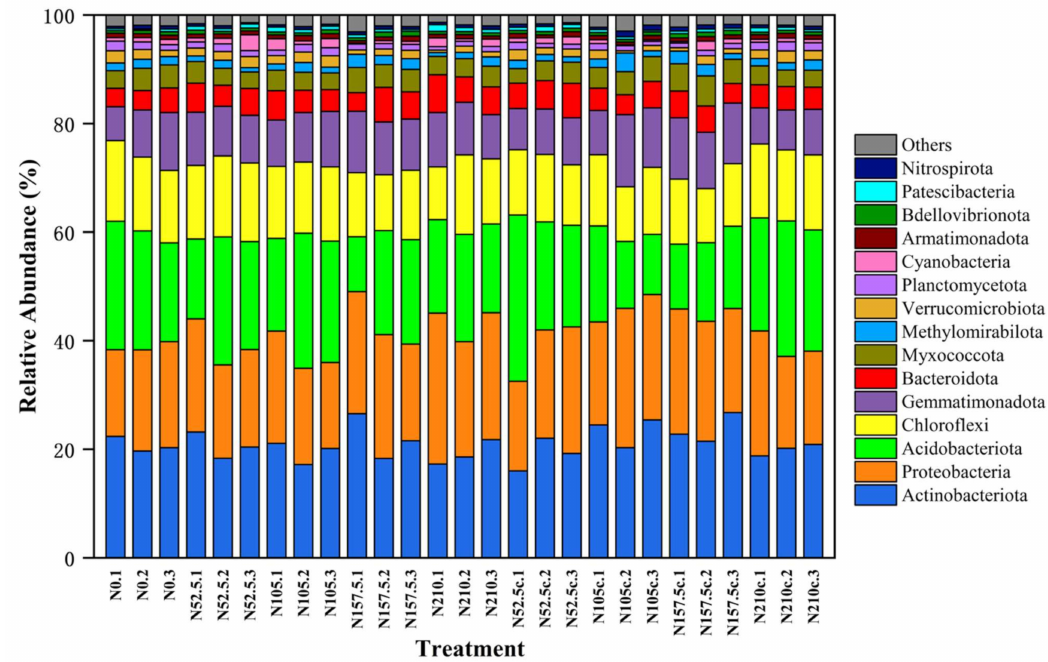
Figure 2. Relative abundance of top 15 soil bacterial phyla for all samples. N0, 0 kg N ha − 1 year − 1 ; N52.5, 52.5 kg N ha − 1 year − 1 ; N105, 105 kg N ha − 1 year − 1 ; N157.5, 157.5 kg N ha − 1 year − 1 ; N210, 210 kg N ha − 1 year − 1 ; N52.5c, 52.5 kg N ha − 1 2 year; N105c, kg N ha − 1 2 year; N157.5c, 157.5 kg N ha − 1 2 year; N210c, kg N ha − 1 2 year. Treatments labeled with 1, 2, and 3 represent 3